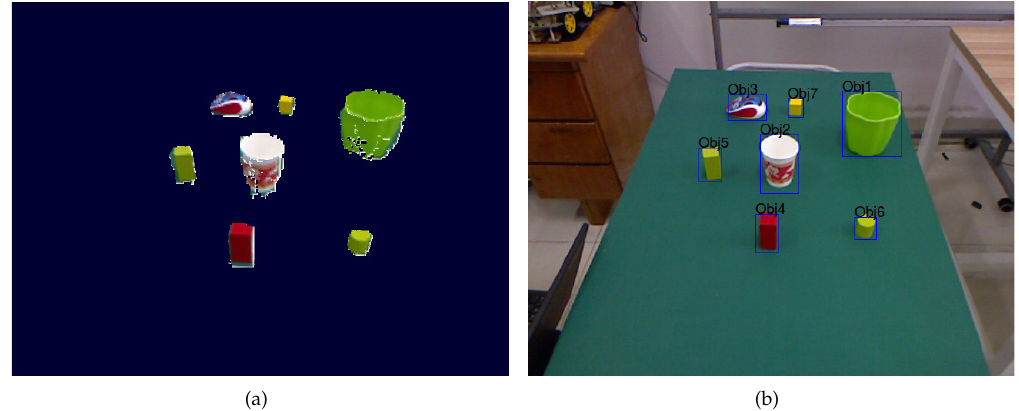
Figure 2. The object segmentation result of the sample scene. ( a ) shows the outputted RGB-D objects. For a better view, they are projected to the RGB image ( b ) where each object is associated with a bounding box and internally